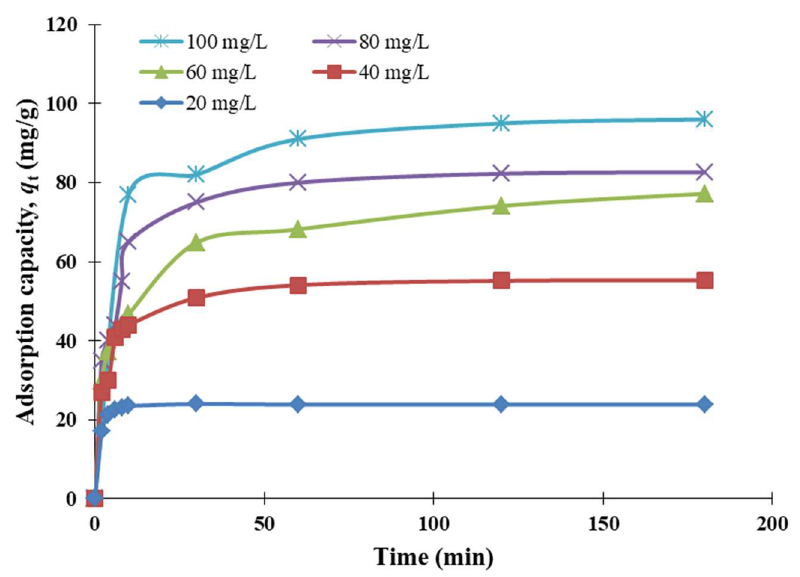
Figure 7. Effect of contact time on MB removal.